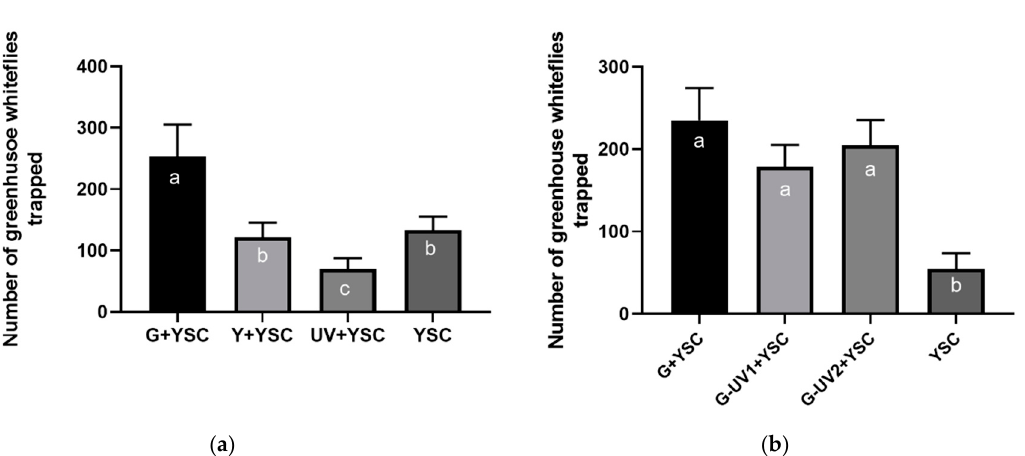
Figure 6. Identifying the most attractive LED light for T. vaporariorum . ( a ) Experiment 1, comparison between yellow, green, and UV lights; ( b ) Experiment 2, comparison between green light and its combination with different ratios of UV light. YSC, yellow sticky card; G, green LED light; Y, yellow LED light; UV, ultraviolet LED light; G-UV1, green and UV LED light ratio 2:1; G-UV2, green and UV LED light ratio 1:1. The di ff erent letters within each column indicate significant di ff erences at p < 0.05 by the LSD test. Error bars represent the standard